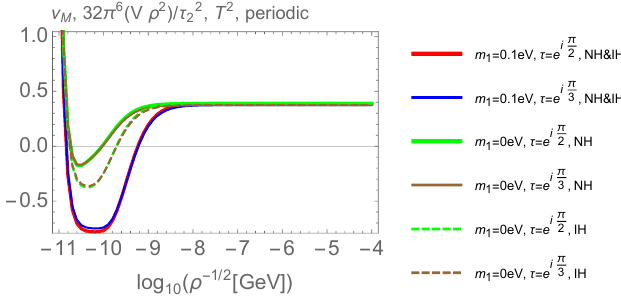
Figure 14 . Periodic Majorana neutrino. The potential for the volume moduli (cid:26)